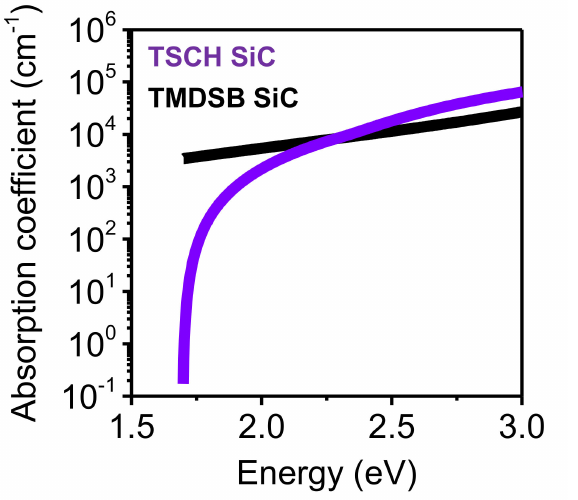
Figure 8. Refractive index (n) and absorption coefficient ( α ) values for as-deposited TSCH-derived SiC films versus substrate temperature at a wavelength of 500 nm, as determined by ellipsometry.